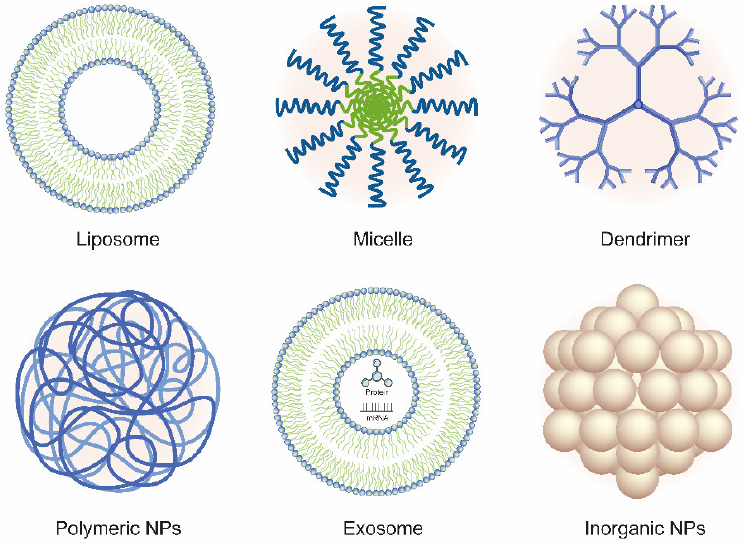
Figure 2. Schematic of the various nanoparticles (NPs) used in the treatment of OA.